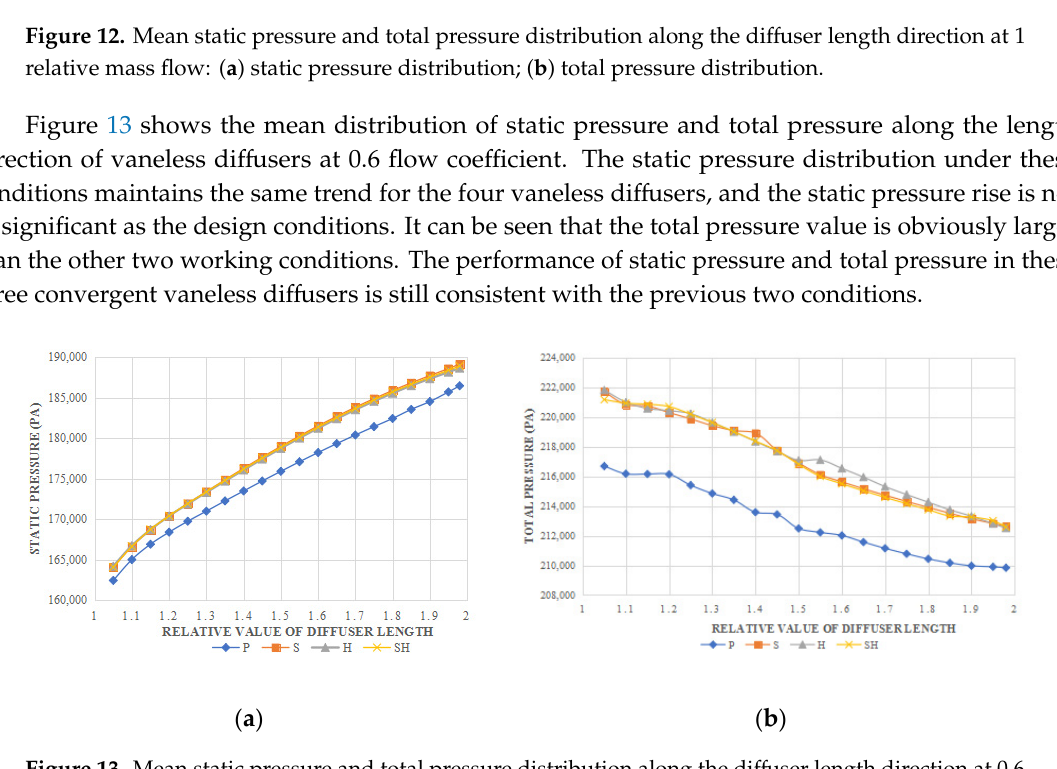
Figure 13. Mean static pressure and total pressure distribution along the diffuser length direction at 0.6 relative mass flow: ( a ) static pressure distribution; ( b ) total pressure distribution.